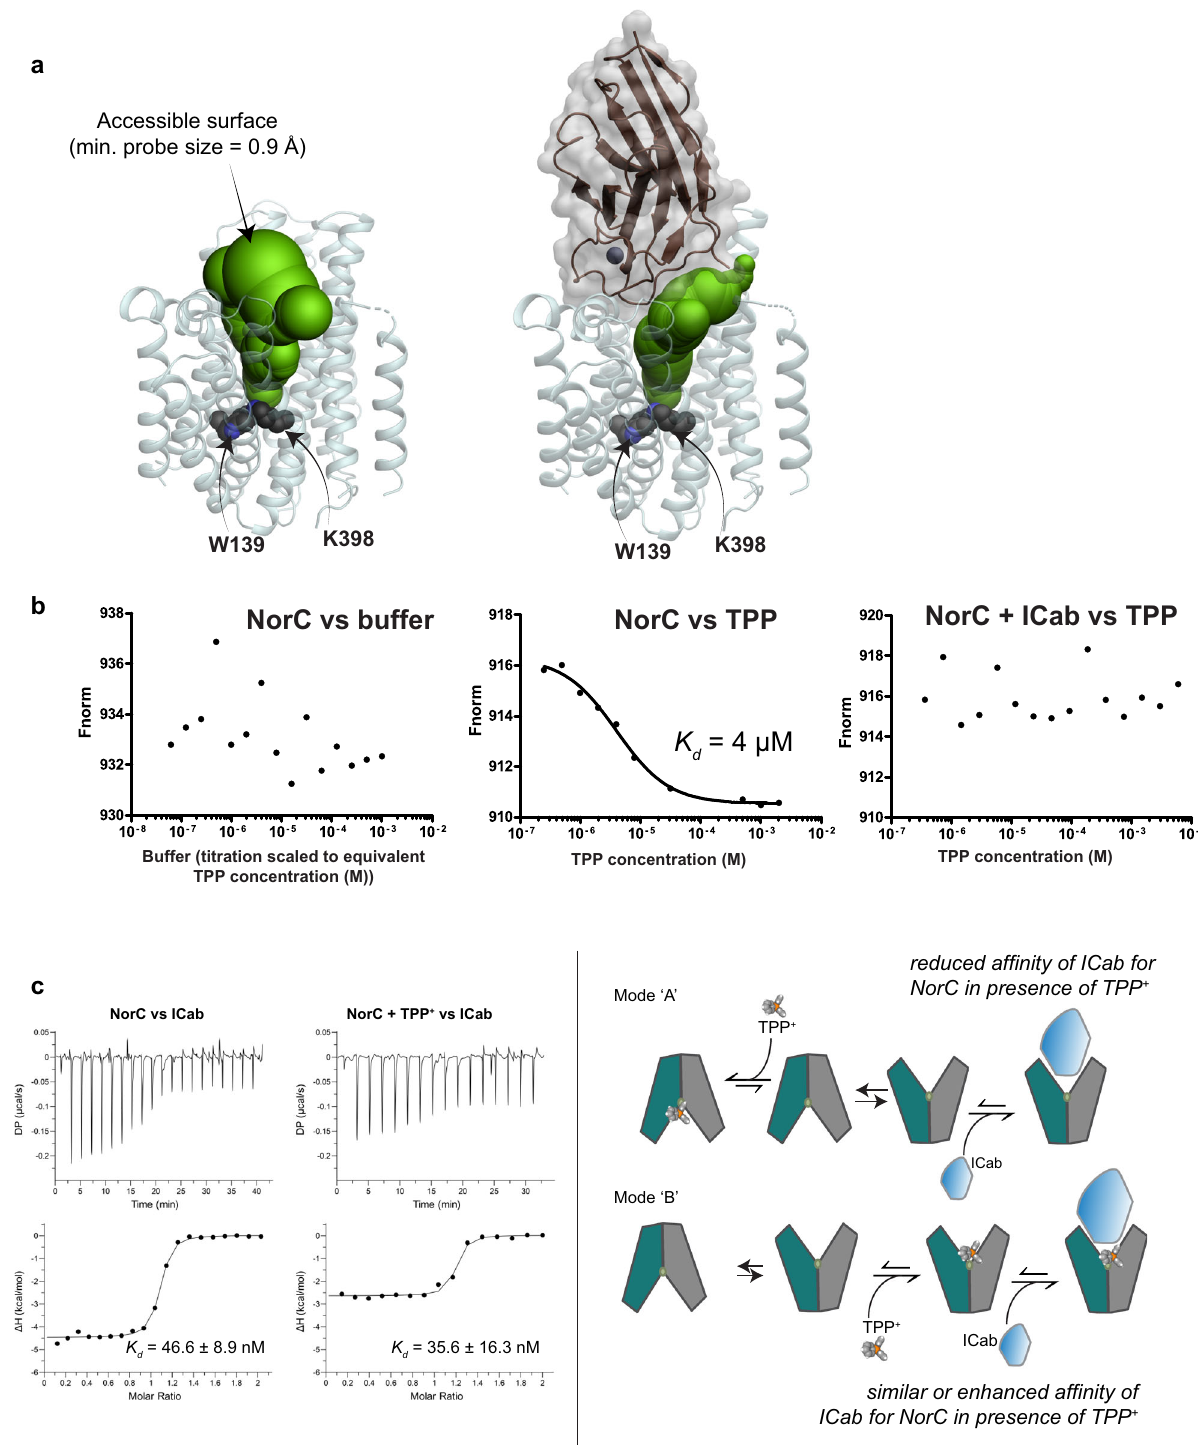
Fig. 4 ICab interaction alters solvent accessibility of NorC vestibule. a Water accessible surface (green spheres) in NorC ’ s vestibule starting from W139/ K398 (black spheres), in the absence (left) and presence (right) of ICab. The outward-open conformation completely blocks accessibility from the cytosolic side of NorC. b Microscale thermophoresis pro fi les for NorC and tetraphenylphosphonium (TPP + ) in the presence and absence of ICab. K d = 4 ± 0.8 μ M for NorC and TPP + . n = 4 for NorC-TPP + titration for independent replicates. The value provided is a concurrent representative from one. c ITC traces of ICab titrated against NorC WT in the presence and absence of TPP + (offset corrected differential power, top panel; baseline subtracted binding isotherm with integrated peaks normalized against moles of injectant, bottom panel) concurs with mode “ B ” of TPP + and ICab binding. n = 2 for independent replicates. Source data is provided in the source data fi